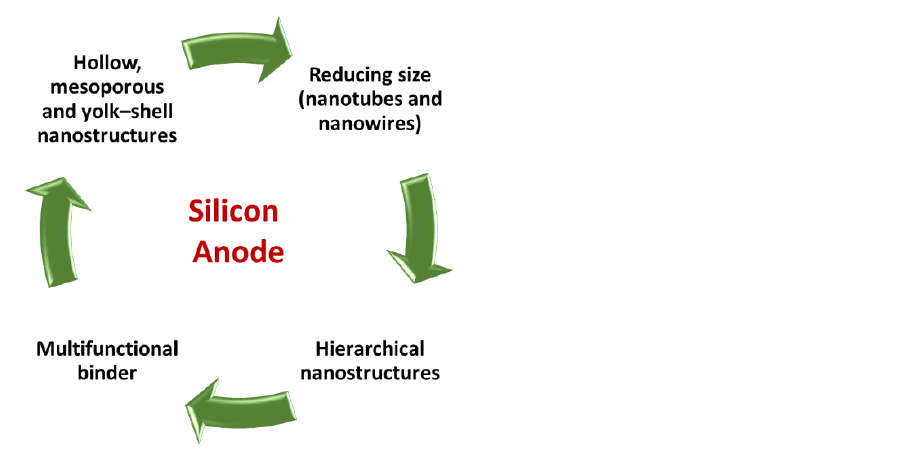
Figure 5. Schematics of several methods for enhancing the performance of Si anodes.